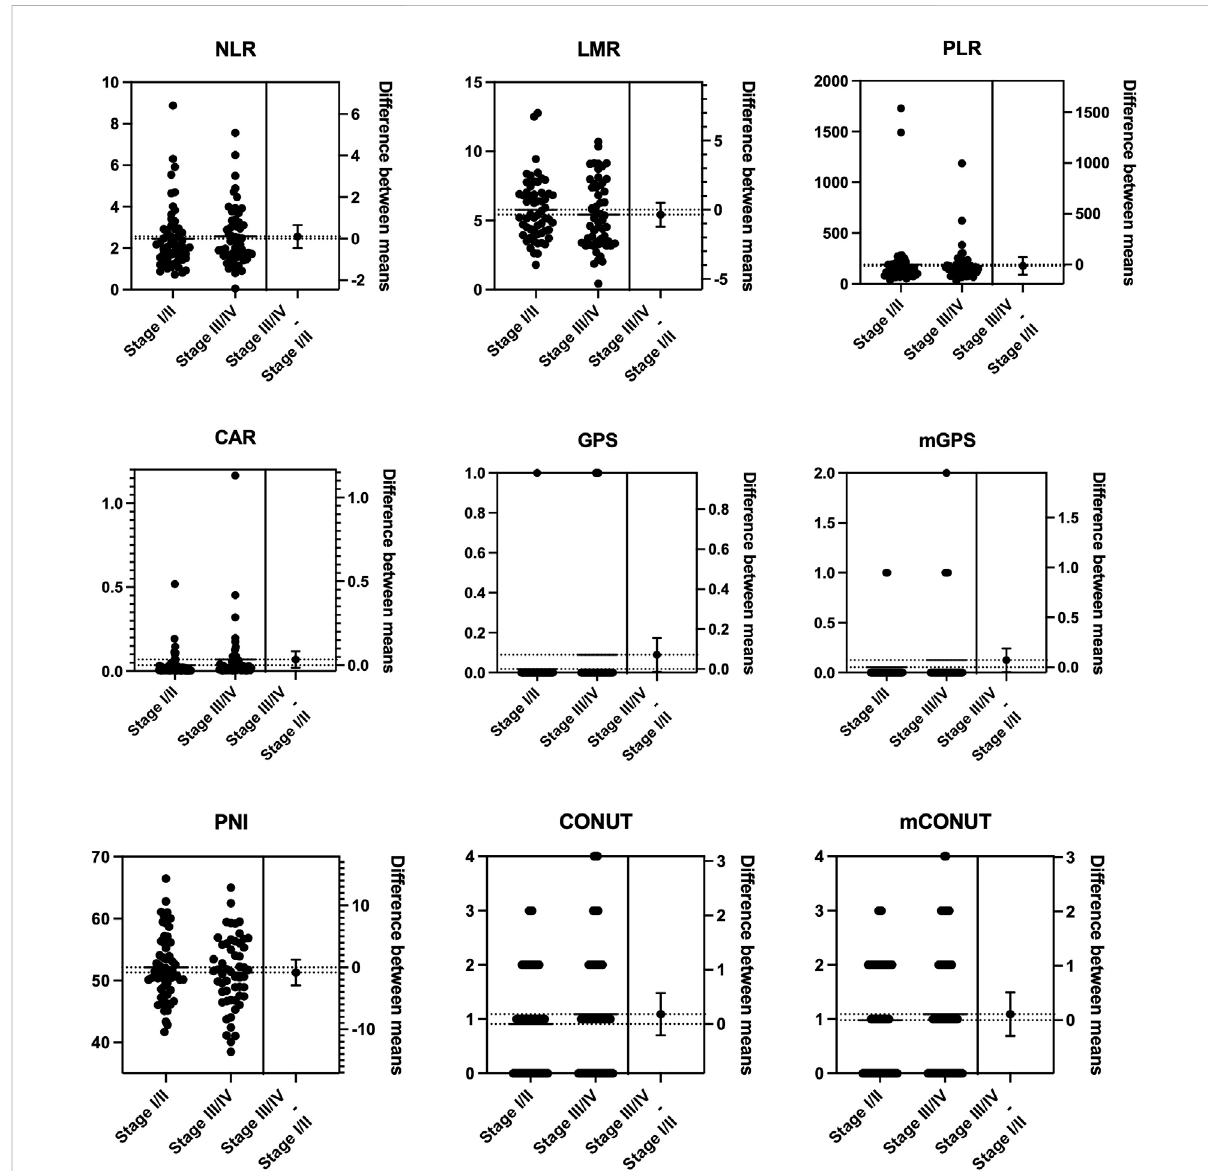
FIGURE 2 Mean comparison of in fl ammation-nutrition markers between the progression of the tumor stage. No signi fi cant differences were observed between stages I/II and III/IV in NLR, LMR, PLR, CAR, GPS/mGPS, PNI, or CONUT/mCONUT. PNI, prognostic nutritional index; NLR, neutrophil- lymphocyte ratio, LMR, lymphocyte – monocyte ratio; PLR, platelet – lymphocyte ratio; CAR, CRP-albumin ratio; GPS, Glasgow prognostic score; mGPS, modi fi ed Glasgow prognostic score; CONUT, controlling nutrition status; mCONUT, modi fi ed controlling nutrition